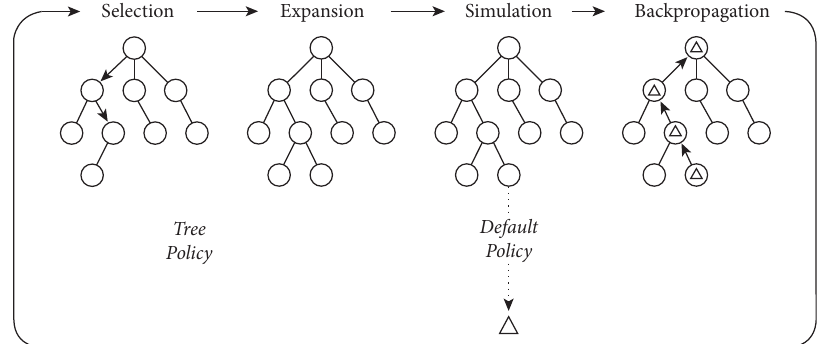
Figure 7: The search procedure diagram for the MCTS algorithm [29].